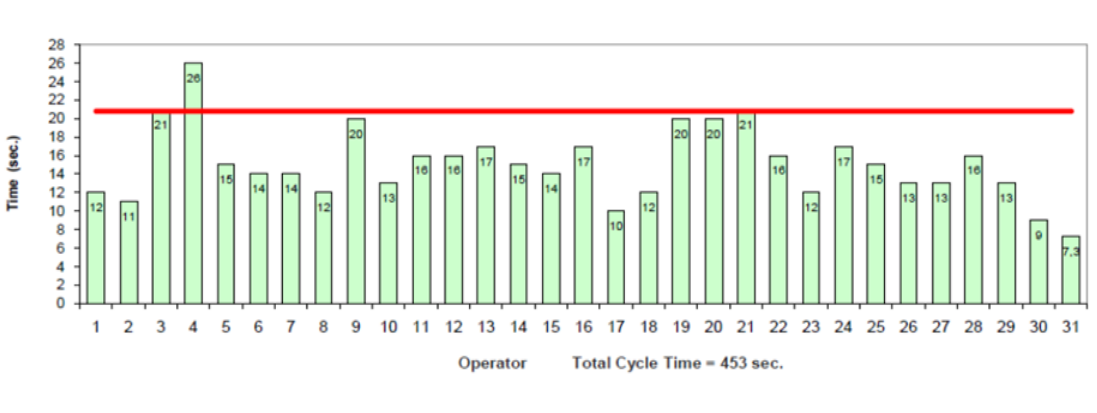
Figure 1. Production Cycle Time Before Kaizen